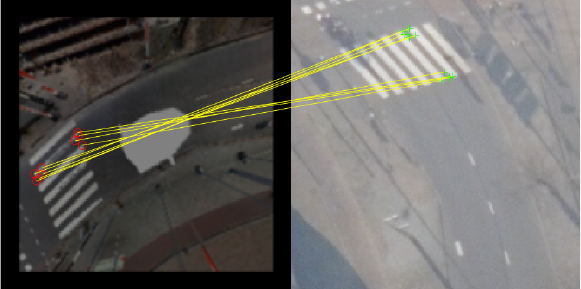
Figure 8. Test area 2; Registration may be hampered due to time difference